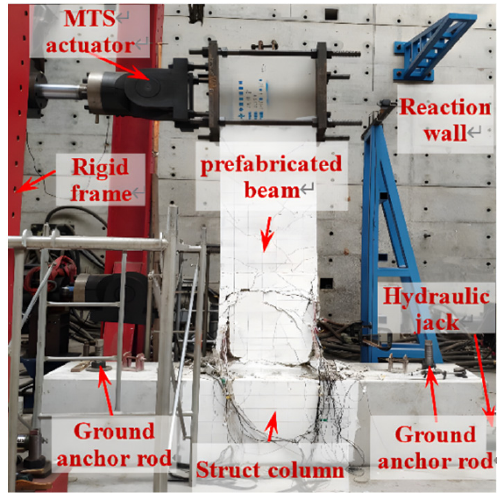
( c ) Figure 6. Fabrication and completion of the test piece: ( a ) Tying of reinforcement cage; ( b ) Second casting; ( c ) Completion of casting. 2.4. Loading Options According to the relevant codes of the Seismic Test Procedure for Buildings